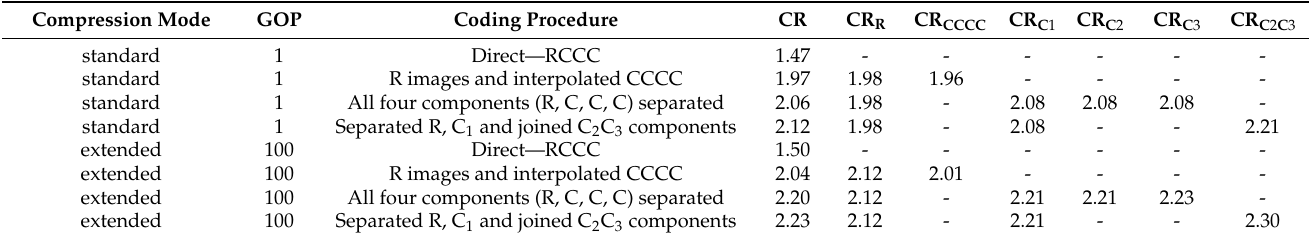
Table 2. Average compression ratios for various lossless coding procedures and division of components.